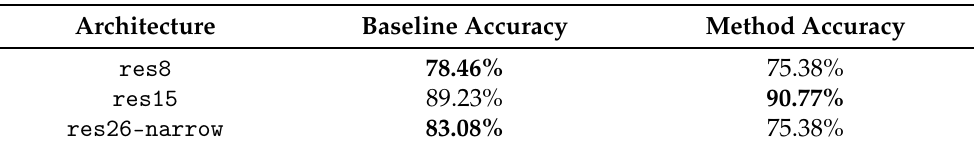
Table 10. Resulting test accuracy after the pre-training on the training set of the Lithuanian data set. The best result for each architecture is highlighted.